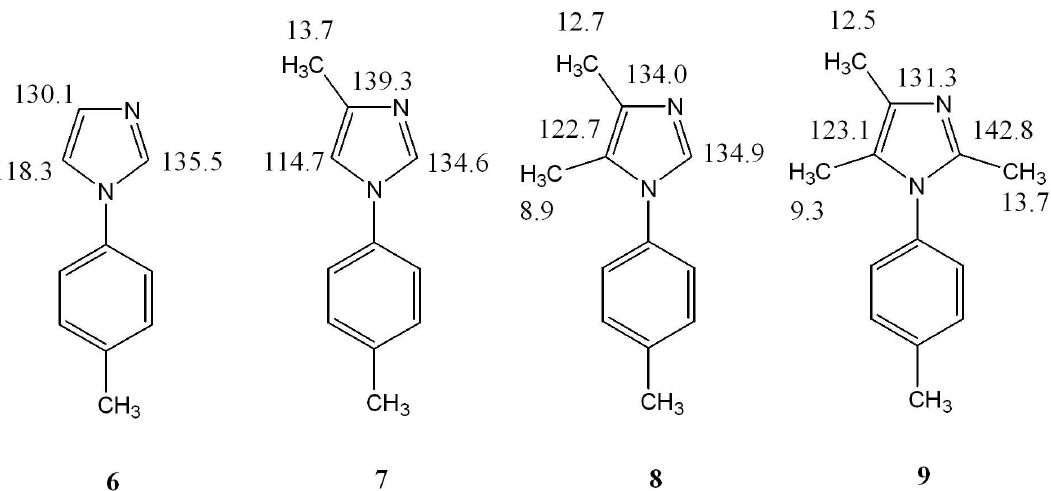
Table 1 13 C NMR chemical shifts (ppm referenced to TMS) for azoles 1 - 5 in CDCl 3 .